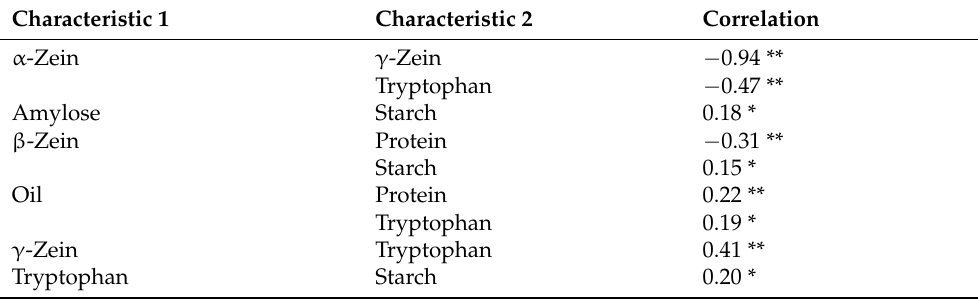
Table 4. Correlations between measured characteristics across all